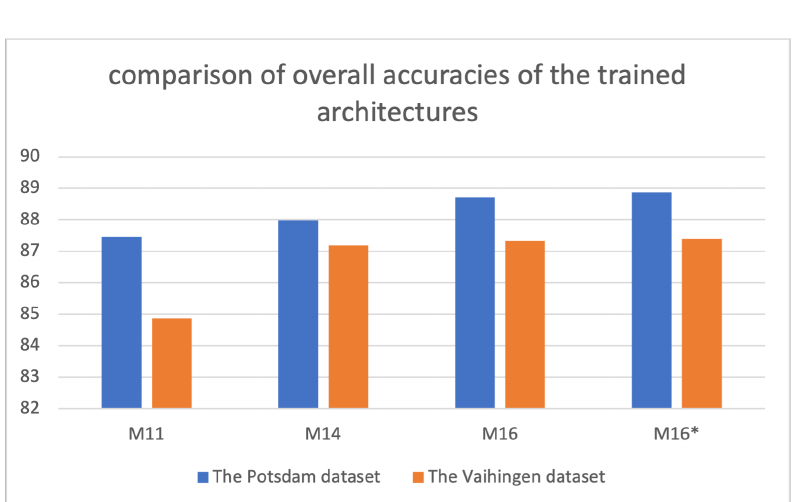
Figure 7. Comparison of overall accuracies of the trained